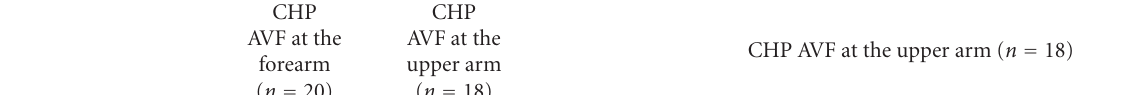
Table 1: Clinical characteristics, biochemical and arterial parameter